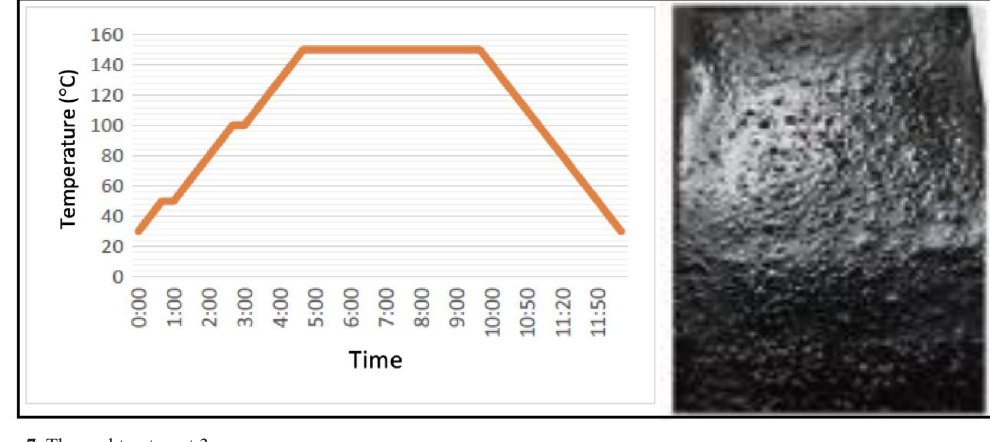
Figure 7. Thermal treatment 3.